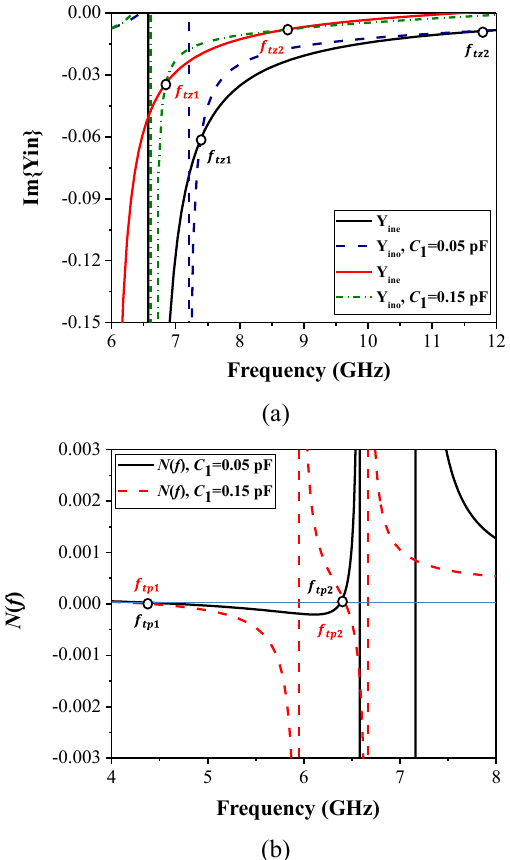
Figure 6: Frequency location of the (a) transmission zeros and (b) transmission poles under different values of C 1 ( L 1 =0.9 nH, L 2 =0.4 nH, C 2 =0.4 pF, C 3 =0.1 pF and L 3 =1.2 nH are fixed).